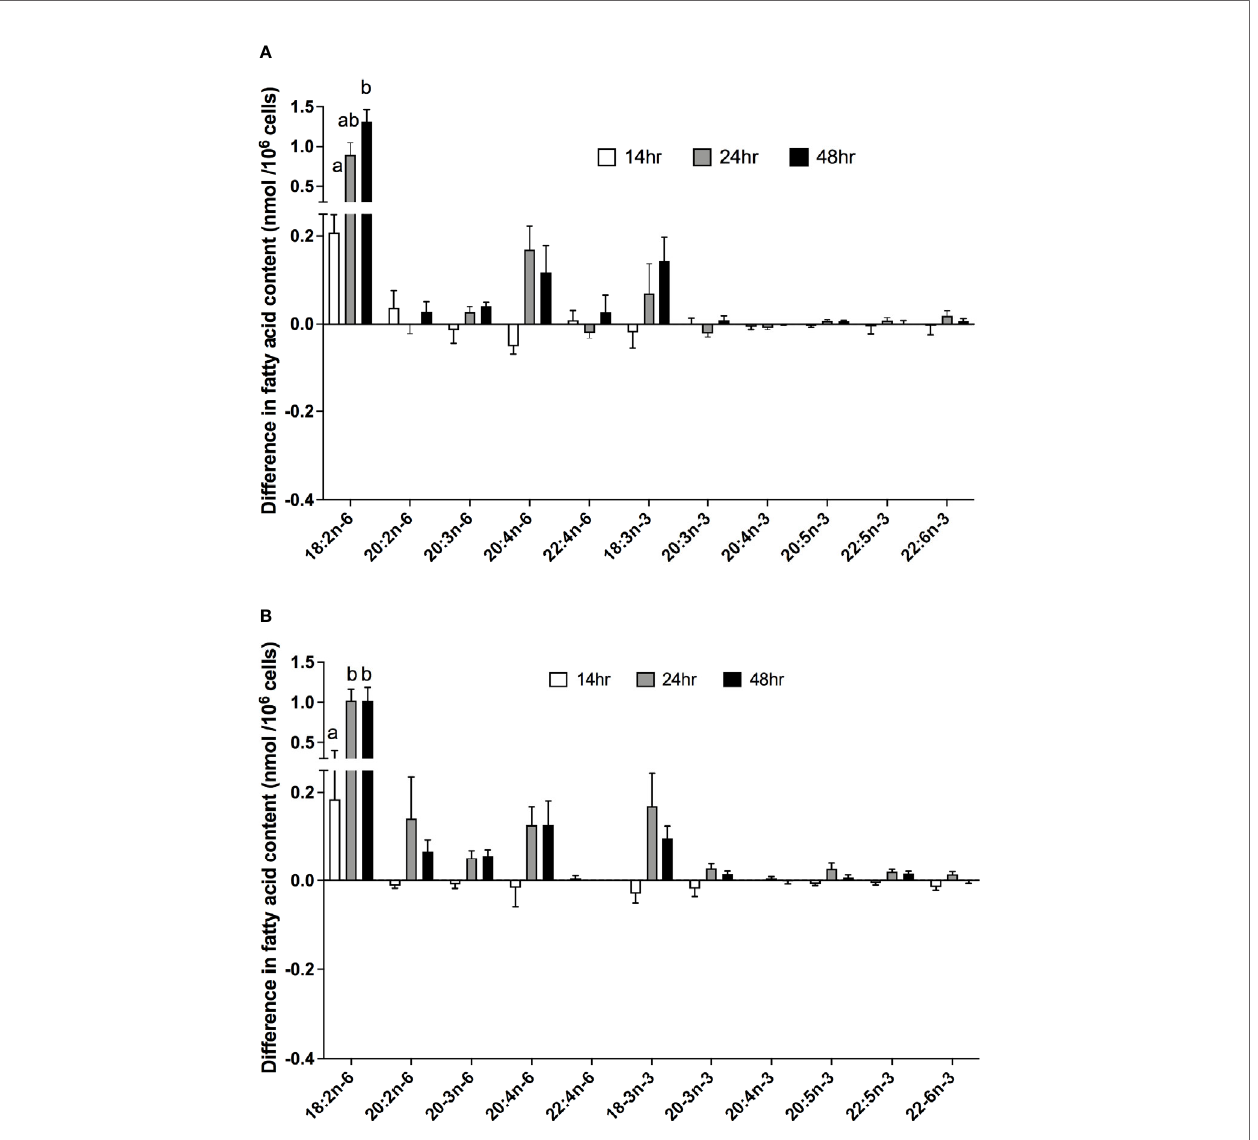
FIGURE 4 | The effect of duration of incubation and essential fatty acid (EFA) ratio on the mitogen-induced change in the amounts of polyunsaturated fatty acids in CD3 + T cells. Values are mean ± SEM (n = 10/time point) difference in the amount of fatty acid in stimulated compared to unstimulated cells after 14-, 24-, and 48-h incubation in media containing an EFA ratio (18:2n-6:18:3n-3) of (A) 5:1 or (B) 8:1. Means represented by bars with different letters were signi fi cantly different by two-way ANOVA with Tukey ’ s post-hoc test. Results of statistical analyses are shown in Table 4